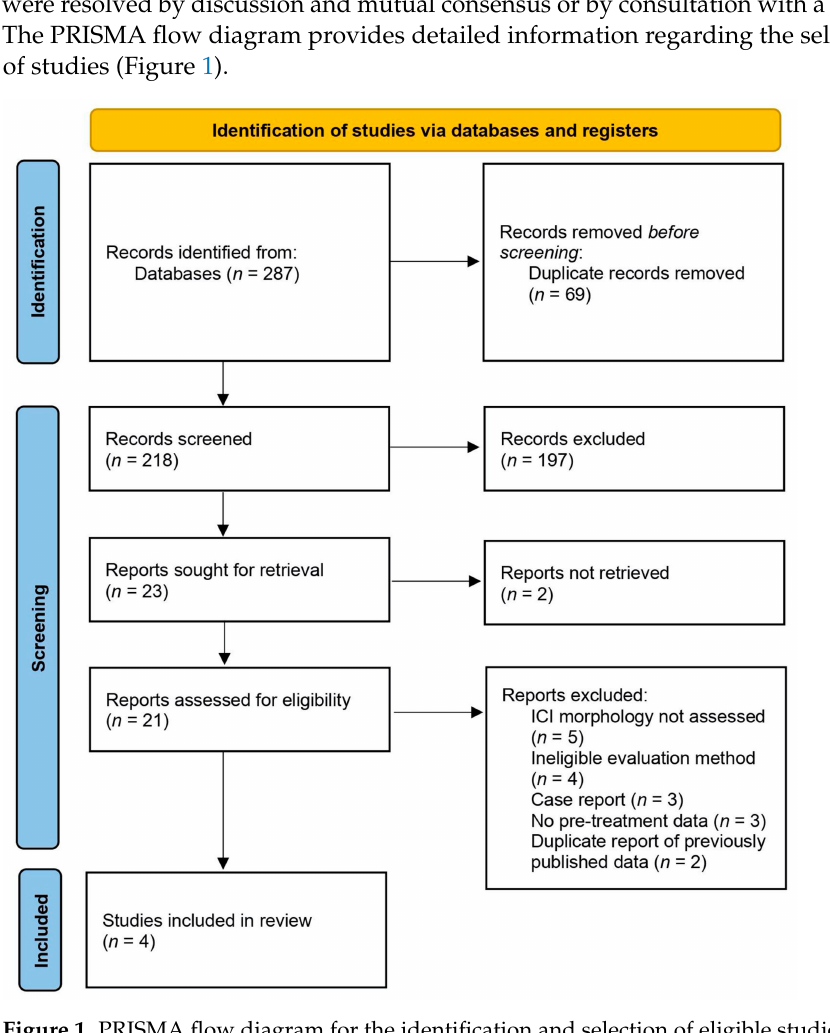
Figure 1. PRISMA flow diagram for the identification and selection of eligible